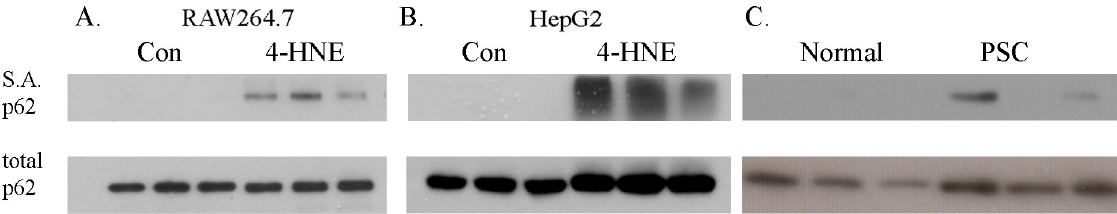
Fig 9. p62 is a target of reactive aldehydes in in vitro cell culture and human PSC. Cells were treated with 100 μ M 4-HNE for 60 min. Cells were lysed, modified proteins were biotinylated using biotin hydrazide and carbonylated proteins purified by streptavidin bead pulldown. Carbonylation of p62 was assessed by Western blotting as described in methods. A . RAW264.7, B . HepG2. C . Carbonylated proteins from control and PSC liver extracts were treated with biotin hydrazide (5mM/60 min) followed by streptavidin purification and p62 Western analysis. N =